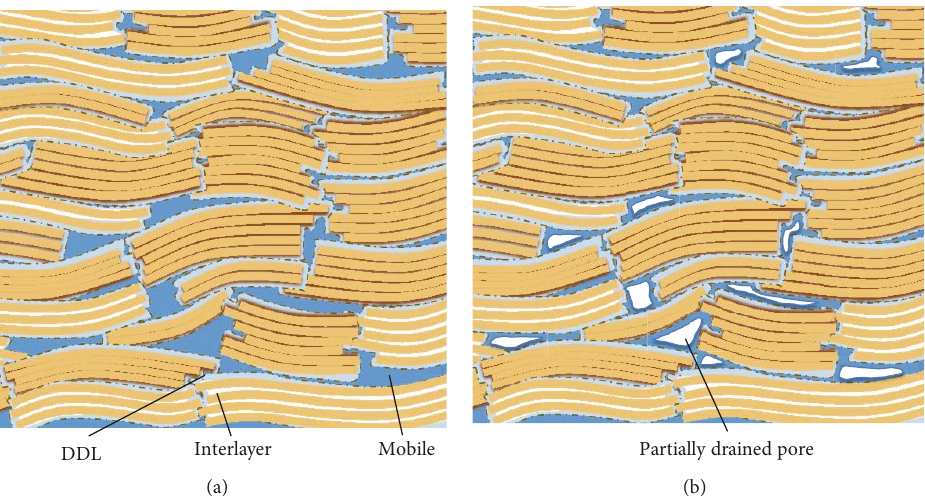
Figure 5: (a) A pore-scale conceptual model of the different porewater fractions found in a low-permeability clay-rich sedimentary rock. (b) The paper-absorption method extracts porewater from the largest interconnected pores. In this example, partially drained pore spaces are assumed to be connected in the third